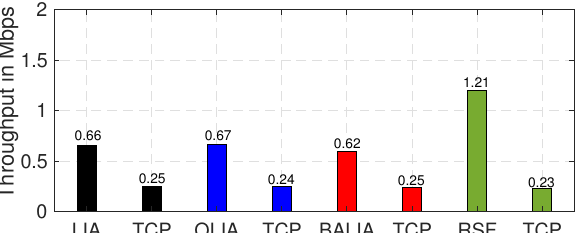
Figure 10. Throughput results for Scenario 9: competing TCP flows. Both paths had 20 Mbps bandwidth, 150 ms delay, and 2% packet loss probability. One path had five additional regular TCP flows, as